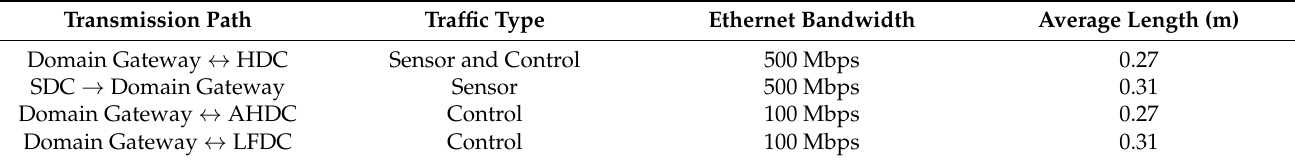
Table 4. Data transmission link parameter of the link connects the DIRA Domain Gateway and each Domain Controllers.